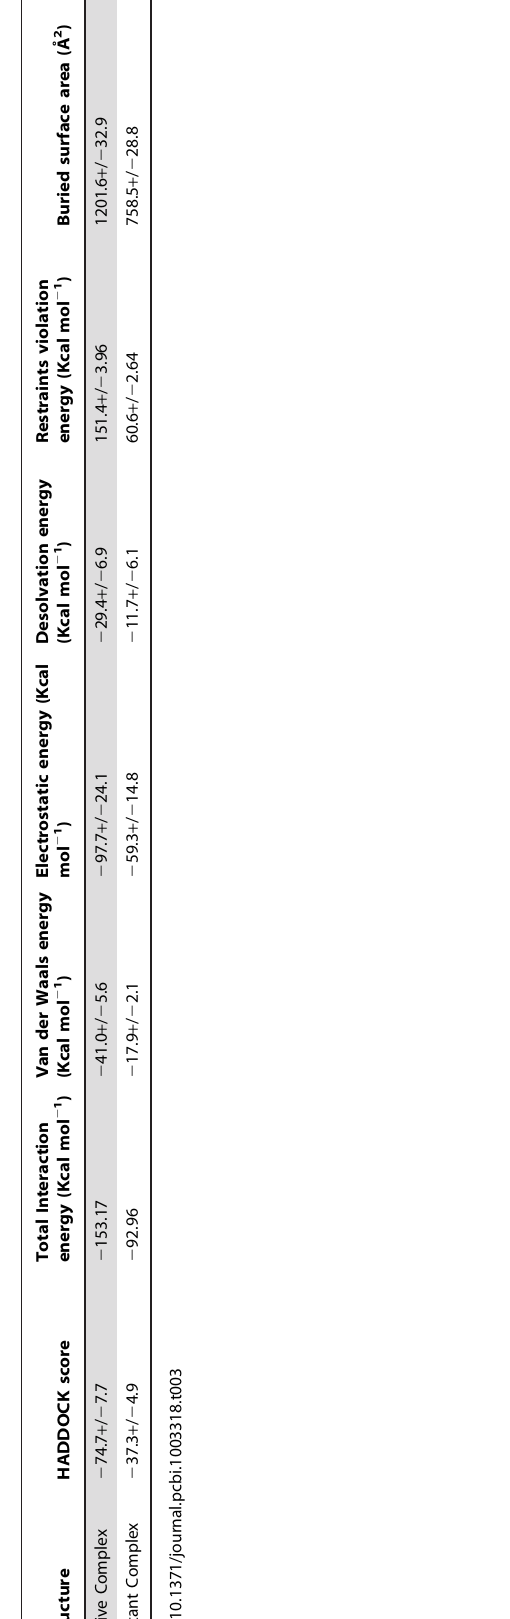
Figure 5. RMSF of the backbone CAs of C a atoms of native and mutant Aurora-A protein versus time at 300 K. Native is shown in black and mutant in red.